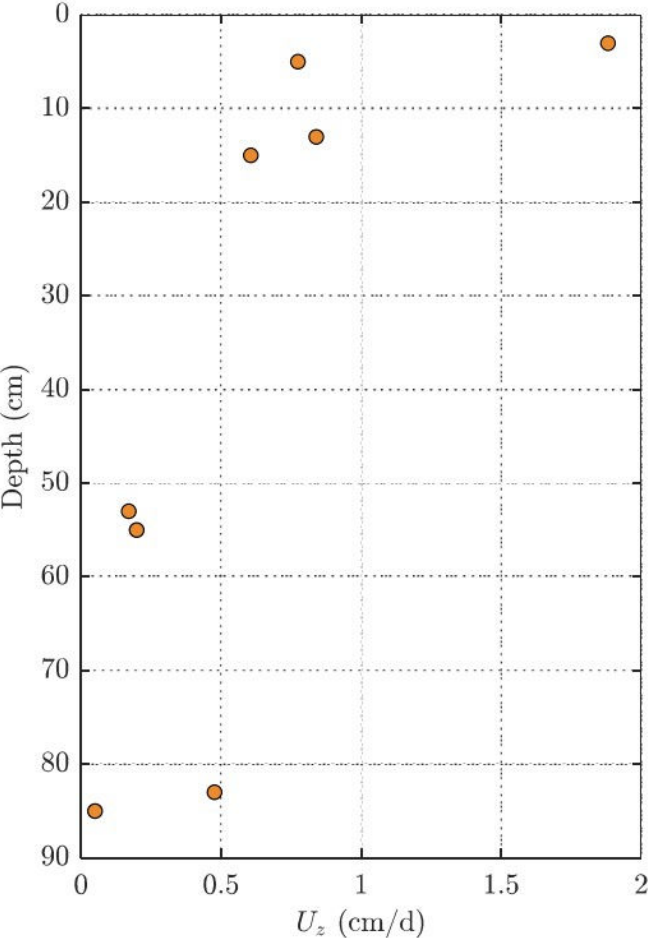
Figure 5. A heat map of the estimated distribution of upwelling groundwater flow (cm/day) averaged across the bottom 10 cm of the SPME sampler within the NW and NE sampling locations. The dots indicate the 24 SPME sampling stations. Microsoft product screen shot(s) reprinted with permission from Microsoft Corporation.